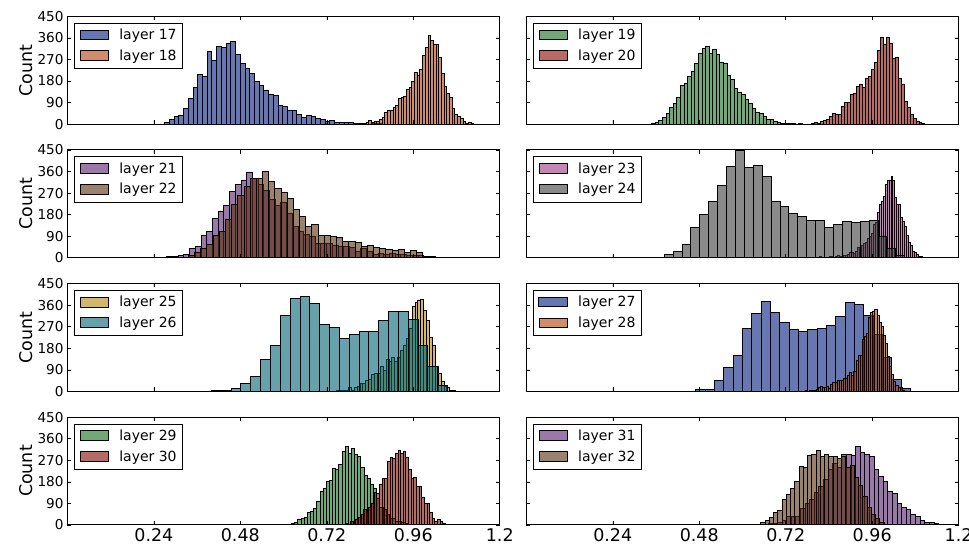
Figure 12. Distribution of KDF histograms for R x at specific layers within selected laminate